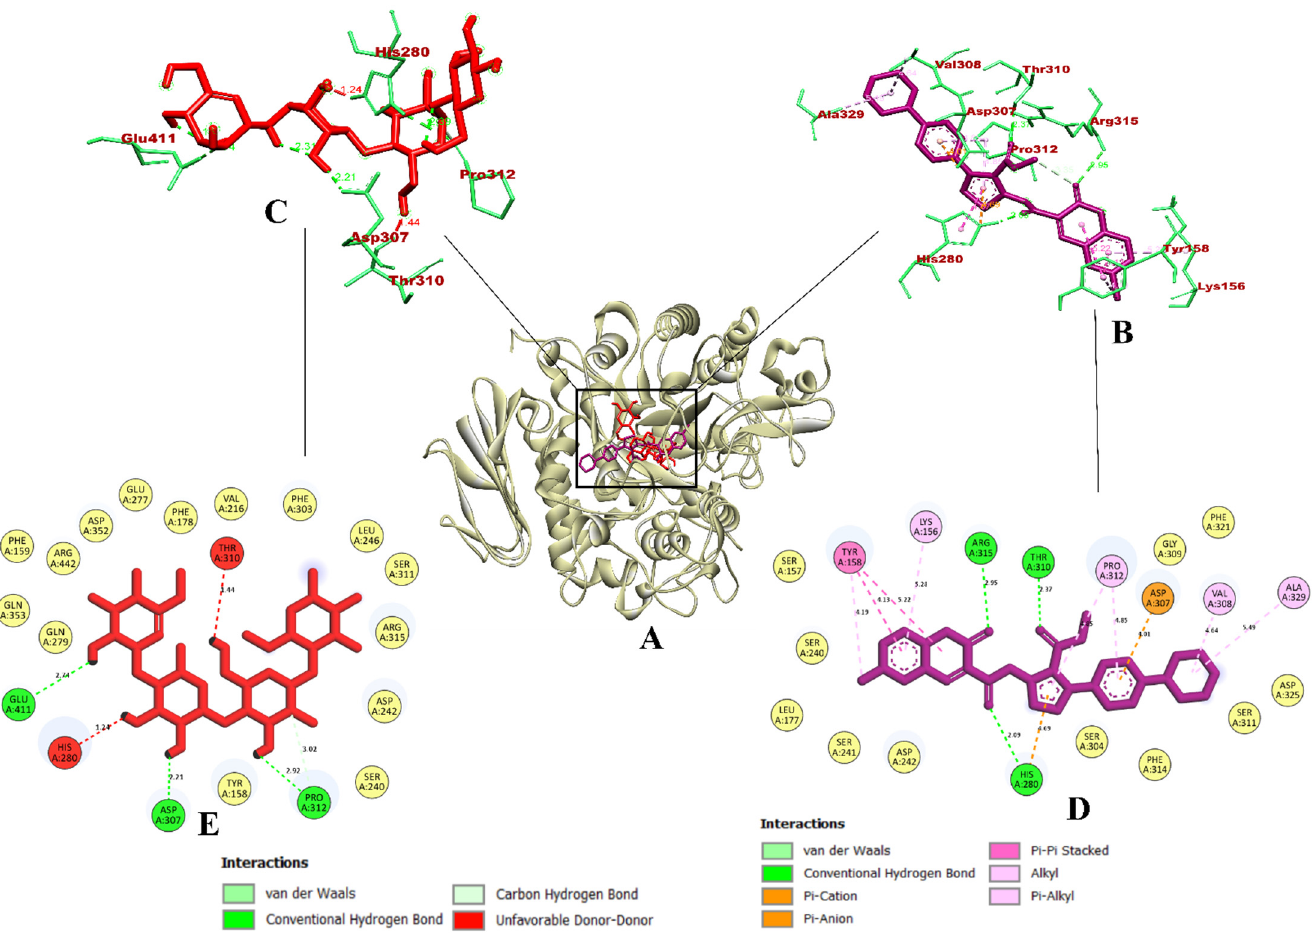
Figure 7. Visualization of binding interaction of ZINC02789441 (violet) and acarbose (red) with α -glucosidase; ( A ) 3D structure of α -glucosidase with bound ZINC02789441 and acarbose in the binding pocket, ( B ) 3D representation of ZINC02789441 binding interactions, ( C ) 3D representation of acarbose binding interactions, and ( D ) 2D representation of ZINC02789441 binding interactions, and ( E ) 2D representation of acarbose binding interactions. Colored: bound residues, yellow: sur- rounding residues.